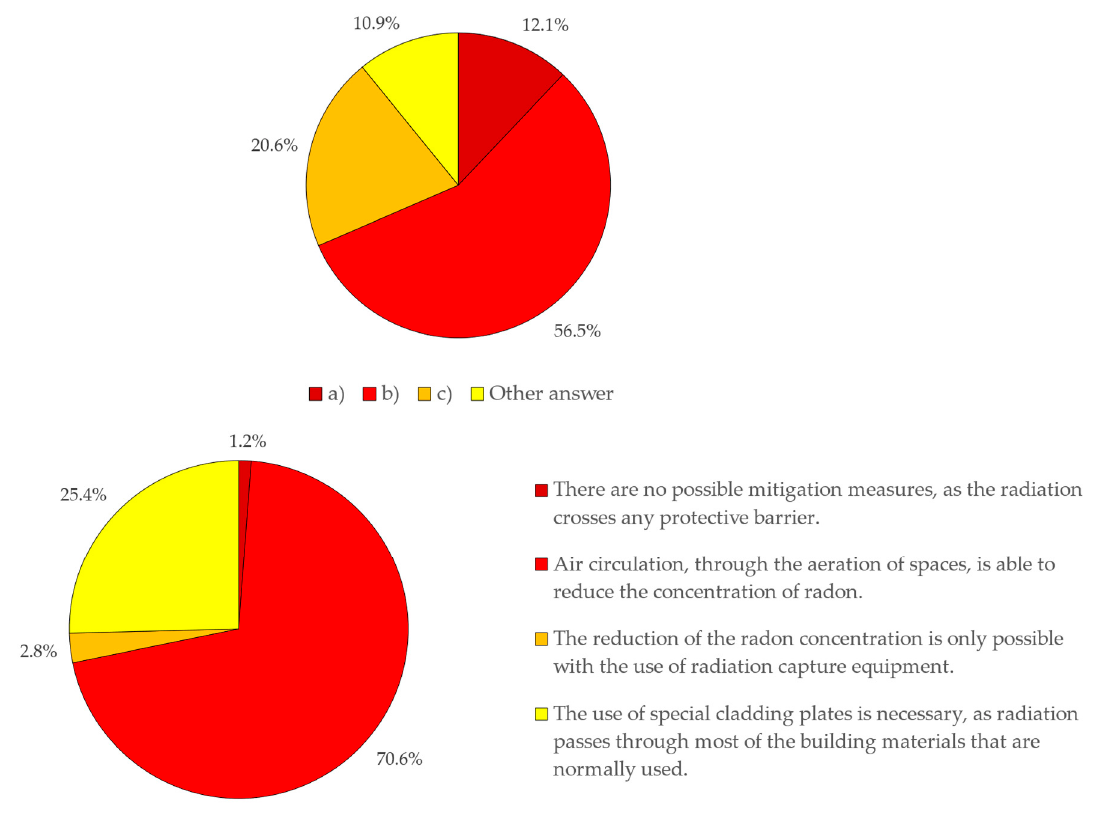
Figure 9. Results extracted from Step 3.